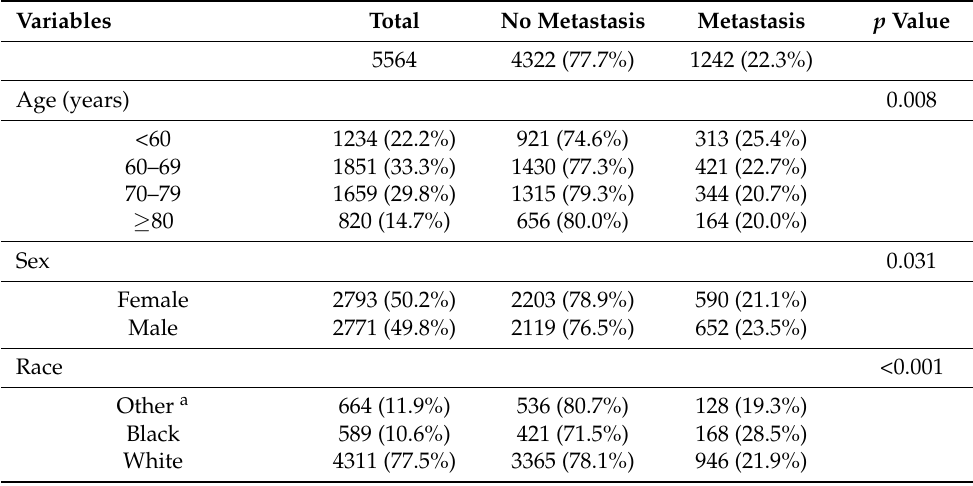
Table 1. Demographic and clinicopathological characteristics of PDAC